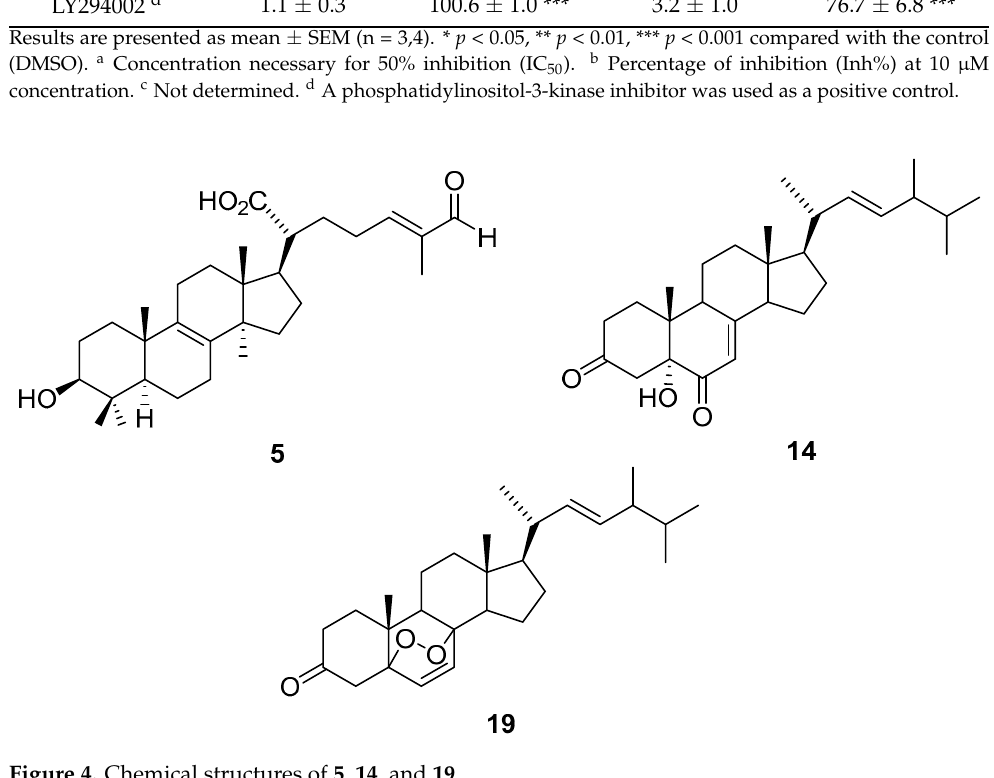
Figure 4. Chemical structures of 5 , 14 , and 19 . Table 4. Binding energies of compounds 5 , 14 , and 19 , and LY294002 calculated in silico.